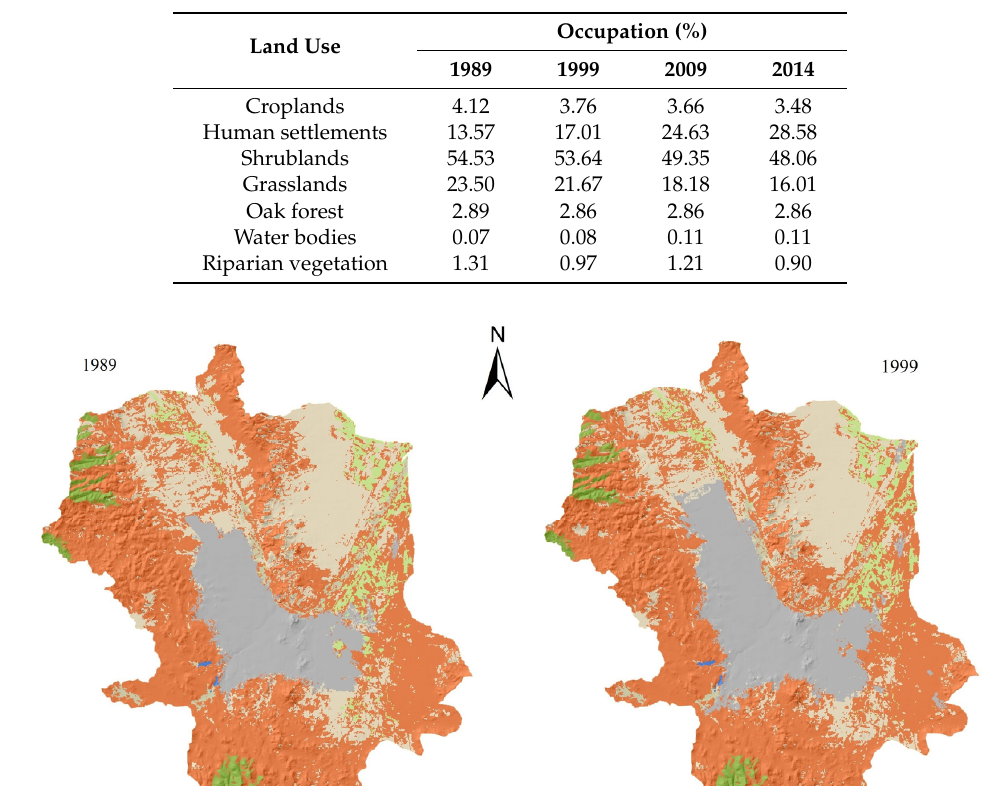
Table 4. Occupation percentages of seven land use types in the urban and peripheral areas of Chihuahua City in 1989, 1999, 2009 and 2014.